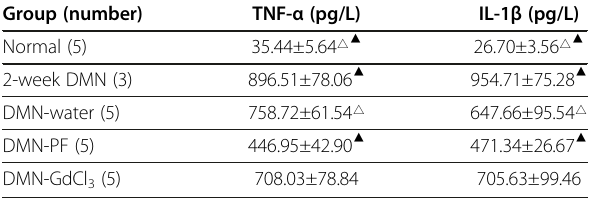
Table 3 Effect of PF on TNF- α and IL-1 β levels in the serum in DMN-induced rat liver fibrosis ( (cid:1) x ± s) Group (number)